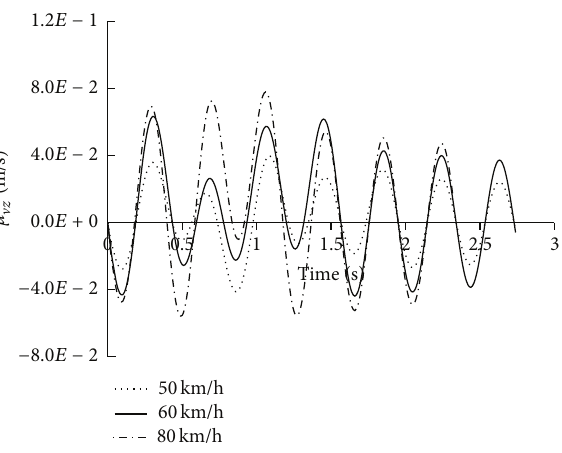
Figure 10: Standard deviation of bridge midspan velocity.